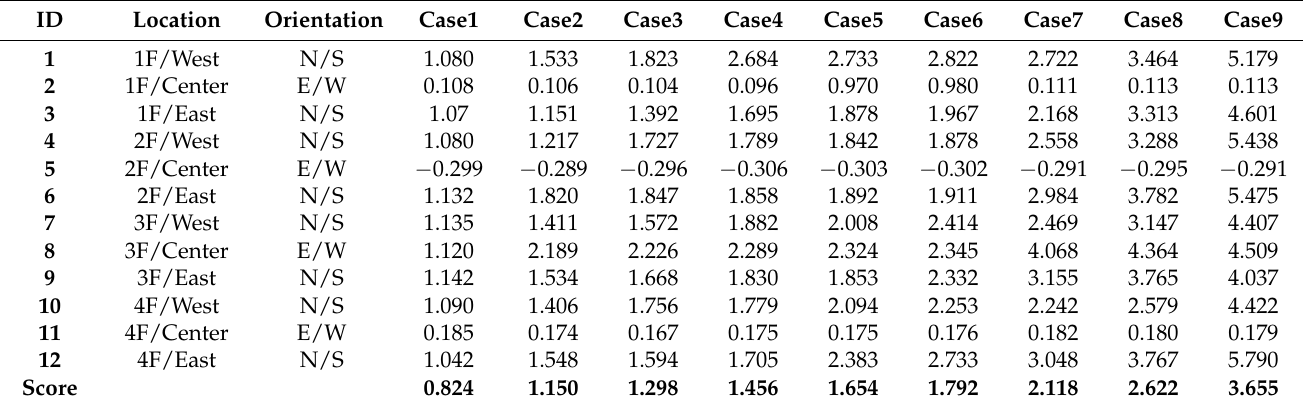
Table 3. Anomaly scores of 12 accelerometers in 9